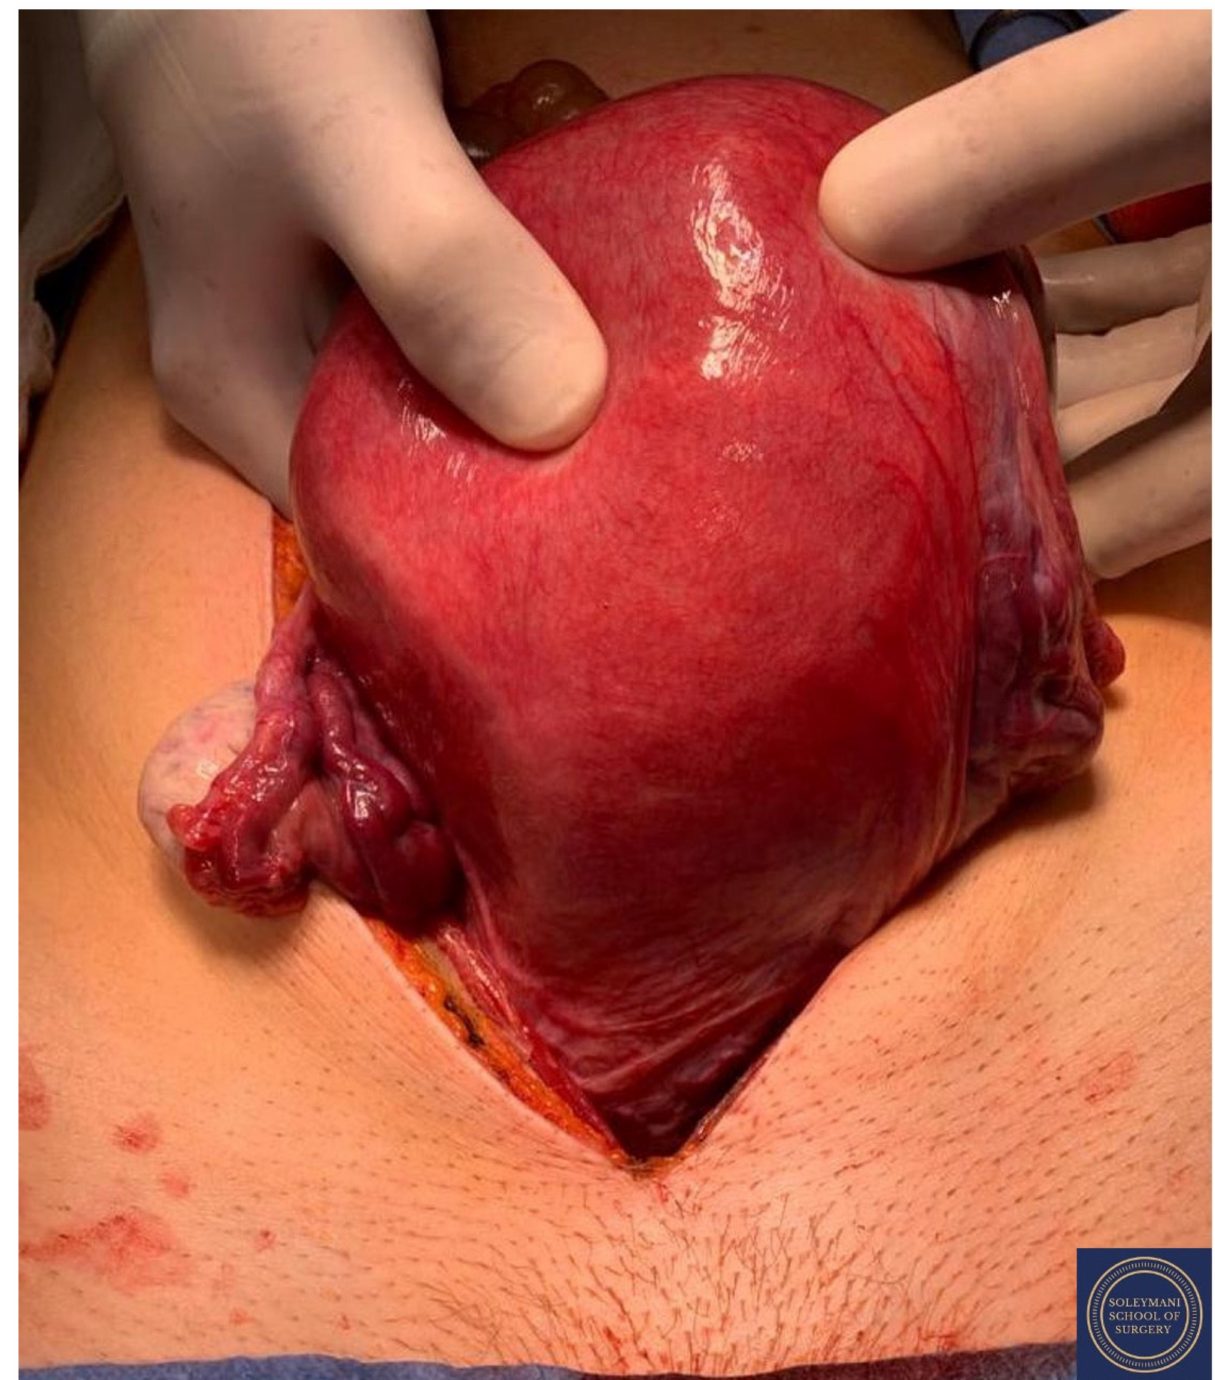
Figure 4. The eighteen-week gravid uterus with foetus